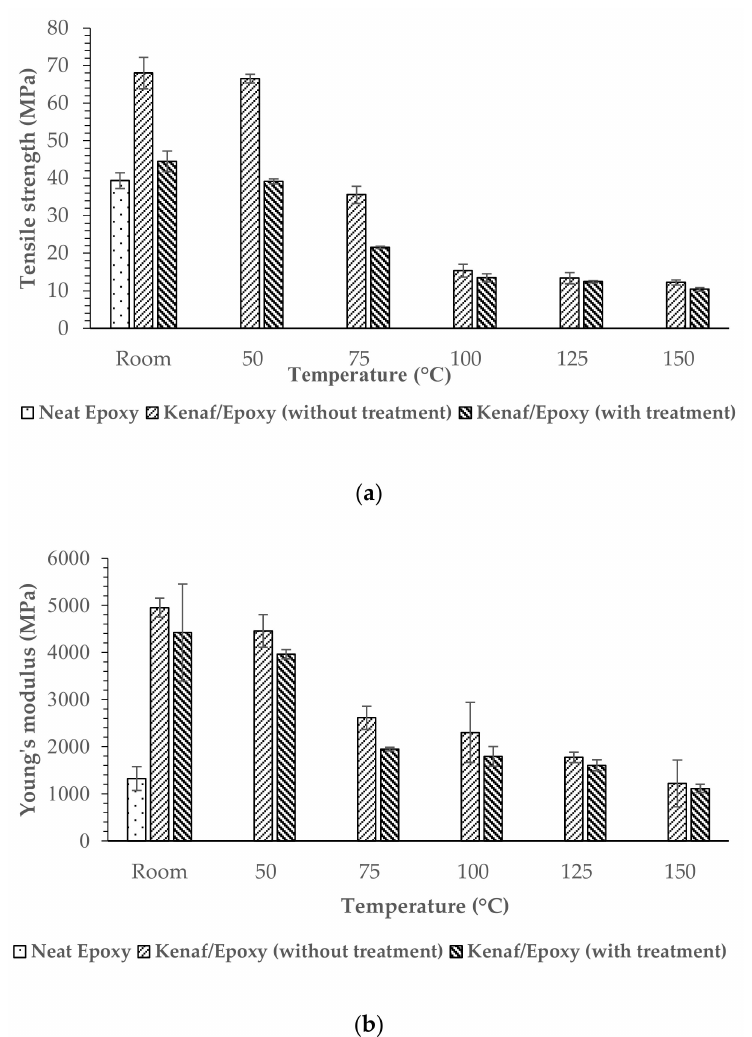
Figure 8. ( a ) Tensile strength and ( b ) Young’s modulus of untreated and treated kenaf/epoxy composites.